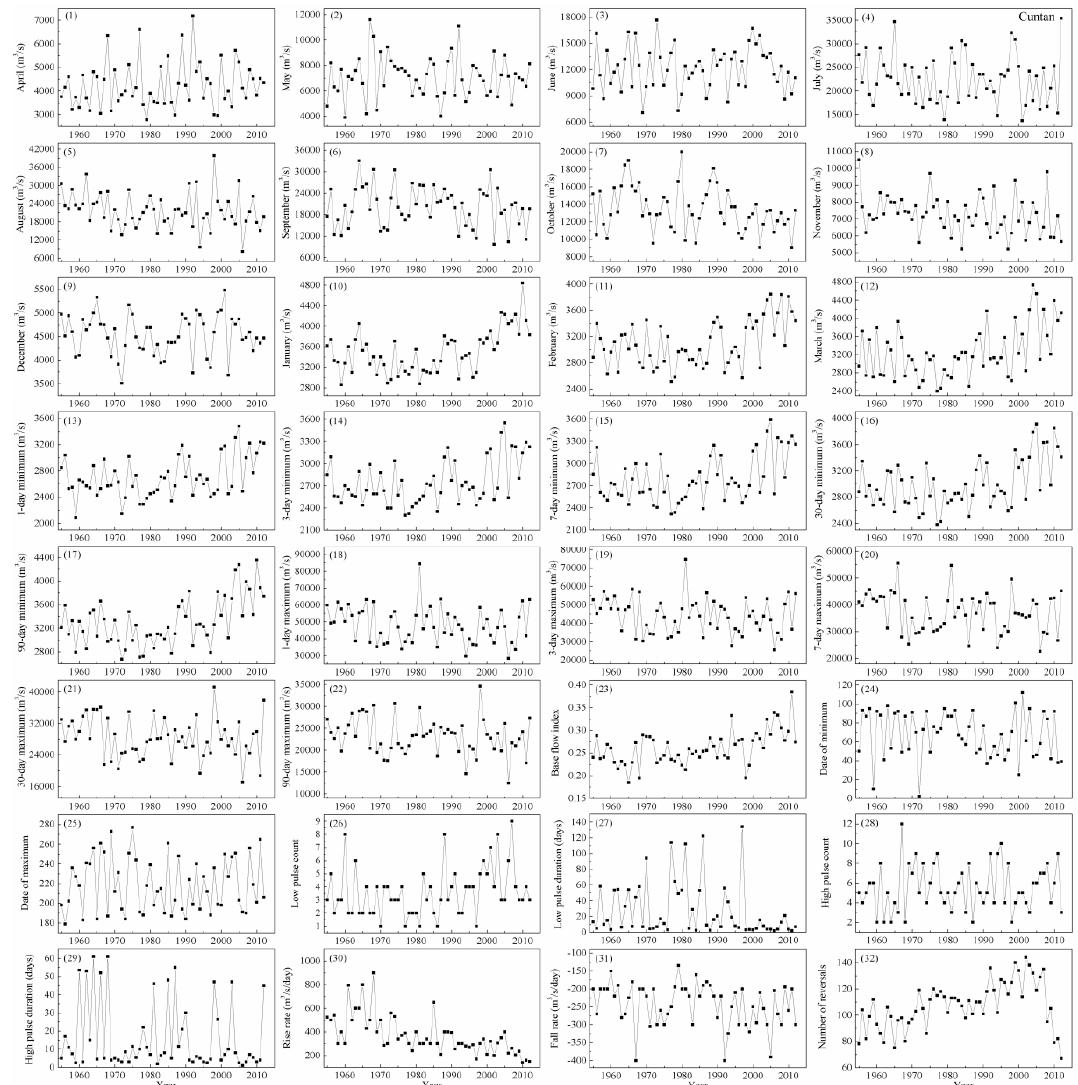
Figure 2. IHA series of the Cuntan station.